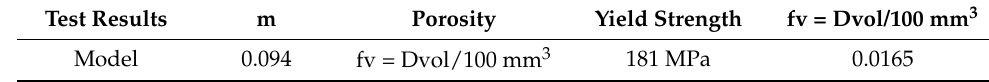
Table 8. Tomography Defect Metrics A3.1 Alloy Set and Porosity Calculation.